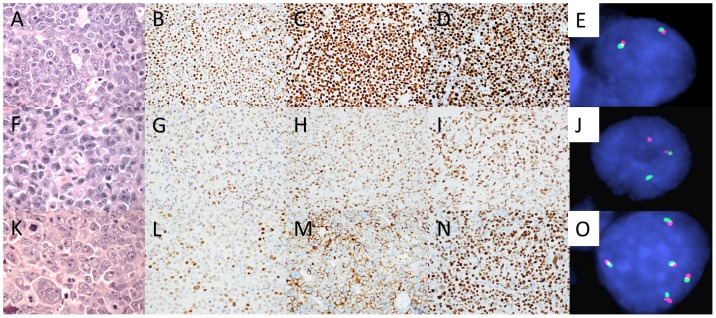
Representative examples of CNS DLBCL harboring or lacking chromosome 8/MYC aberrations.H&E-stained section of a case exhibiting morphologic features intermediate between DLBCL and Burkitt lymphoma (A), 80% MYC expression by the neoplastic cells (B), non-GCB COO subtype - BCL6+ (C) and MUM1/IRF4+ (D), and displaying two normal MYC loci by FISH (two fused signals) (E). H&E-stained section of a case showing immunoblastic morphology (F), 50% MYC expression by the neoplastic cells (G), non-GCB COO subtype - BCL6+ (H) and MUM1/IRF4+ (I), and displaying MYC rearrangement by FISH (one split signal, red and green, and one fused signal) (J). H&E-stained section of a DLBCL showing anaplastic morphology (K), 60% MYC expression by the neoplastic cells (L), GCB COO subtype - CD10+ (M) and BCL6+ (N), and increased copies of MYC by FISH (5 fused signals) (O). Photomicrographs of all H&E-stained sections were taken at 400x magnification and all others at 40x magnification.